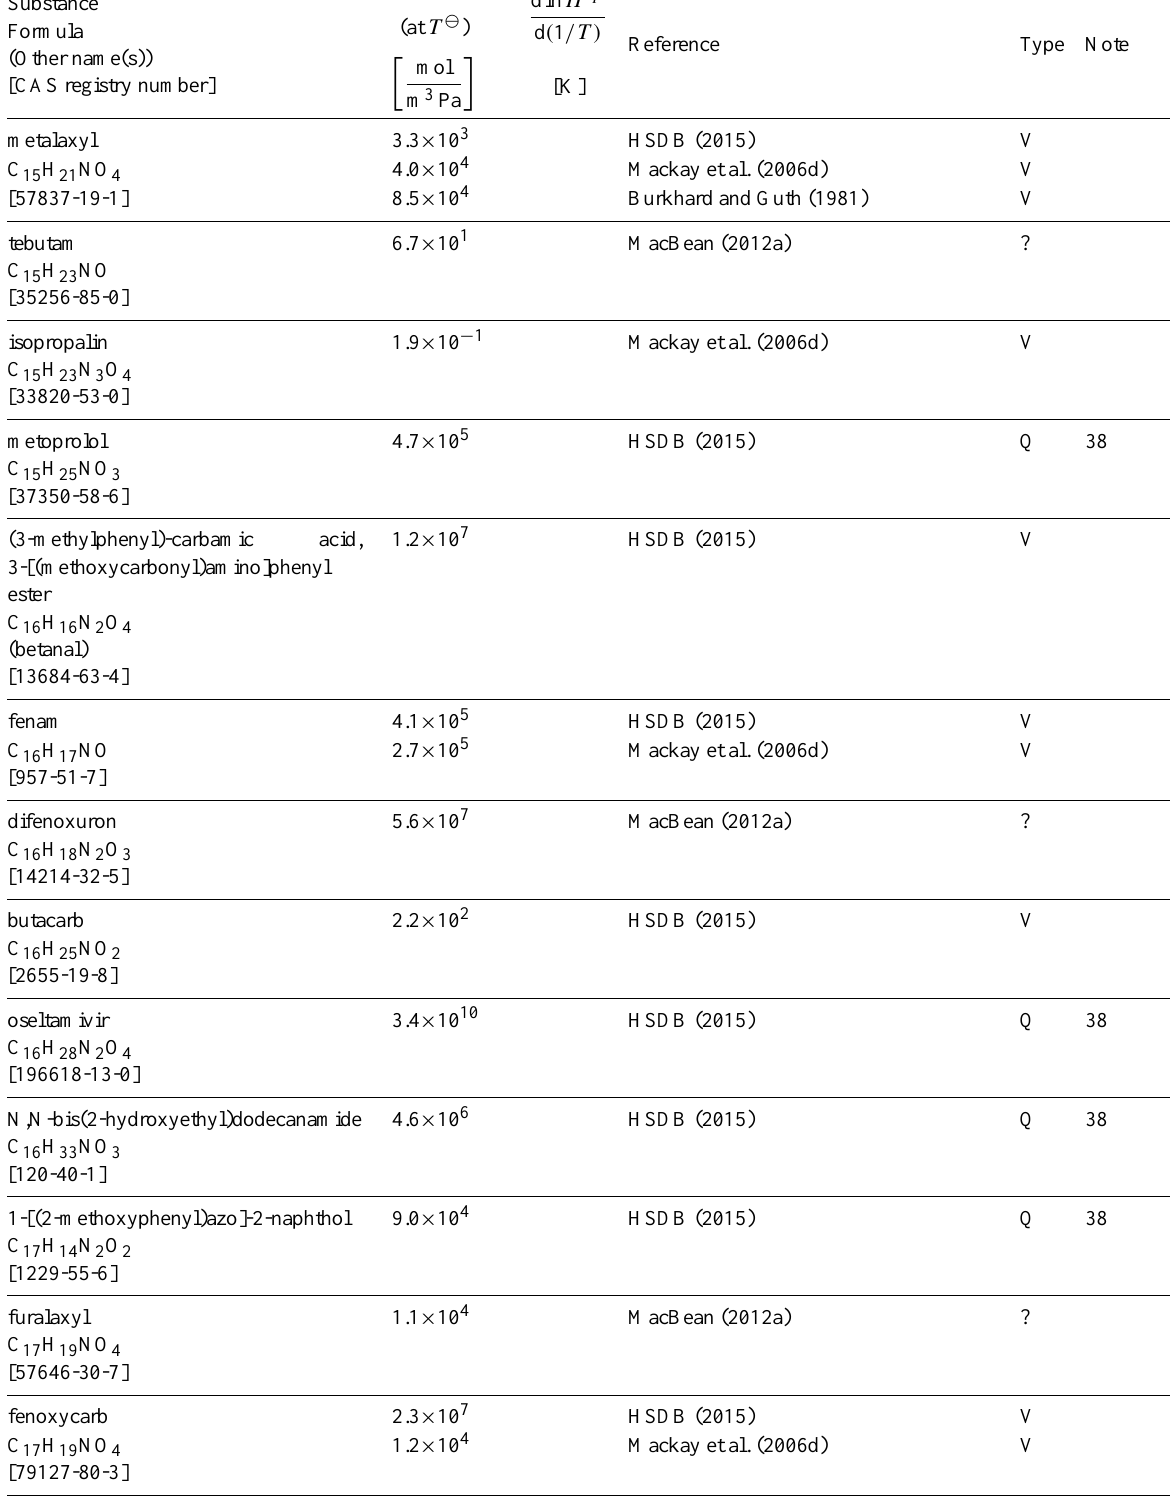
Table 6: Henry’s law constants for water as solvent